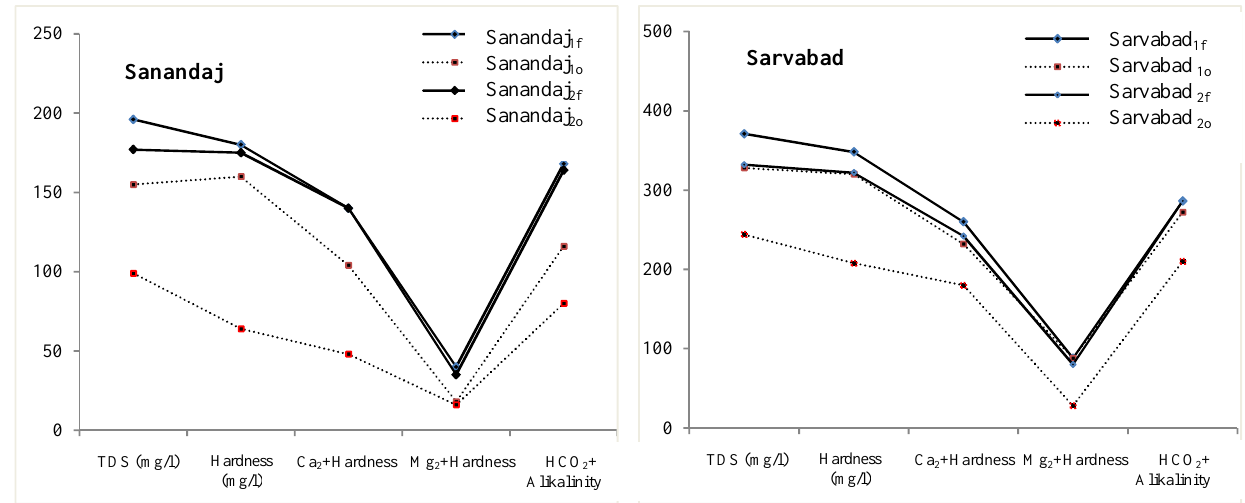
Figure 4. Repeated samples of Sanandaj and Sarvabad TDS: Total dissolved solids